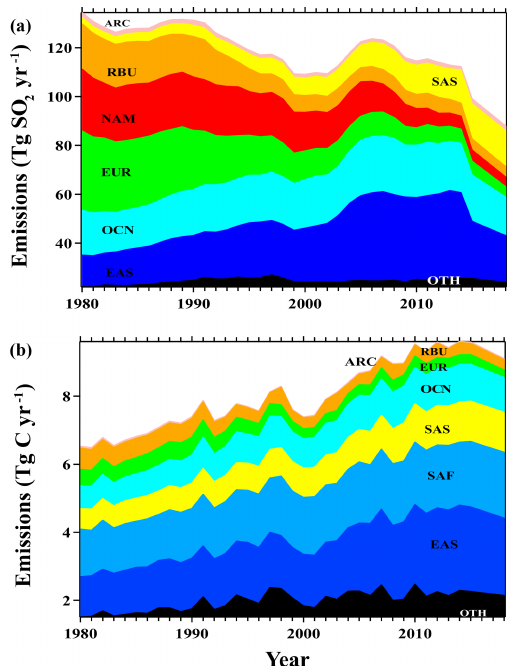
Figure 2. Time series of global total anthropogenic emissions of (a) SO 2 (TgSO 2 yr − 1 ) and (b) BC (TgCyr − 1 ), classified by key an- thropogenic source regions. Emissions from other regions (OTH), including those of ANT, CAM, CAS, MDE, NAF, PAN, SAM, SEA and SAF/NAM, can be found in Fig. S1. Abbreviations for the re- gions can be found in Fig.